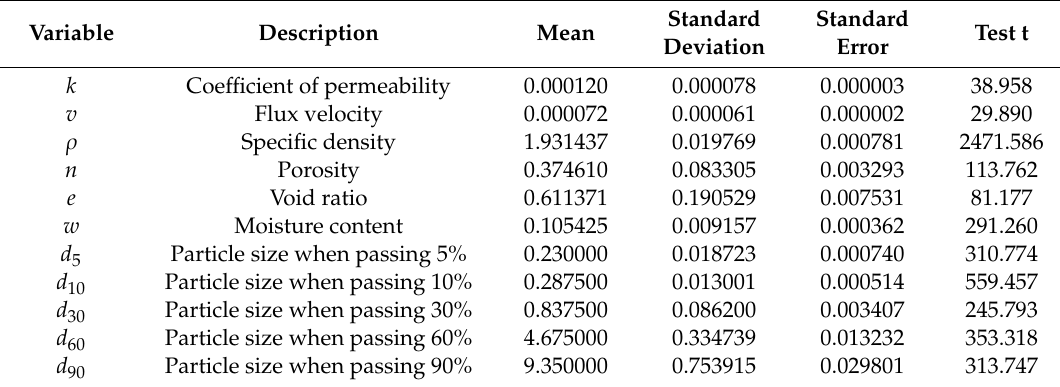
Table 1. Average test against a fixed reference value.